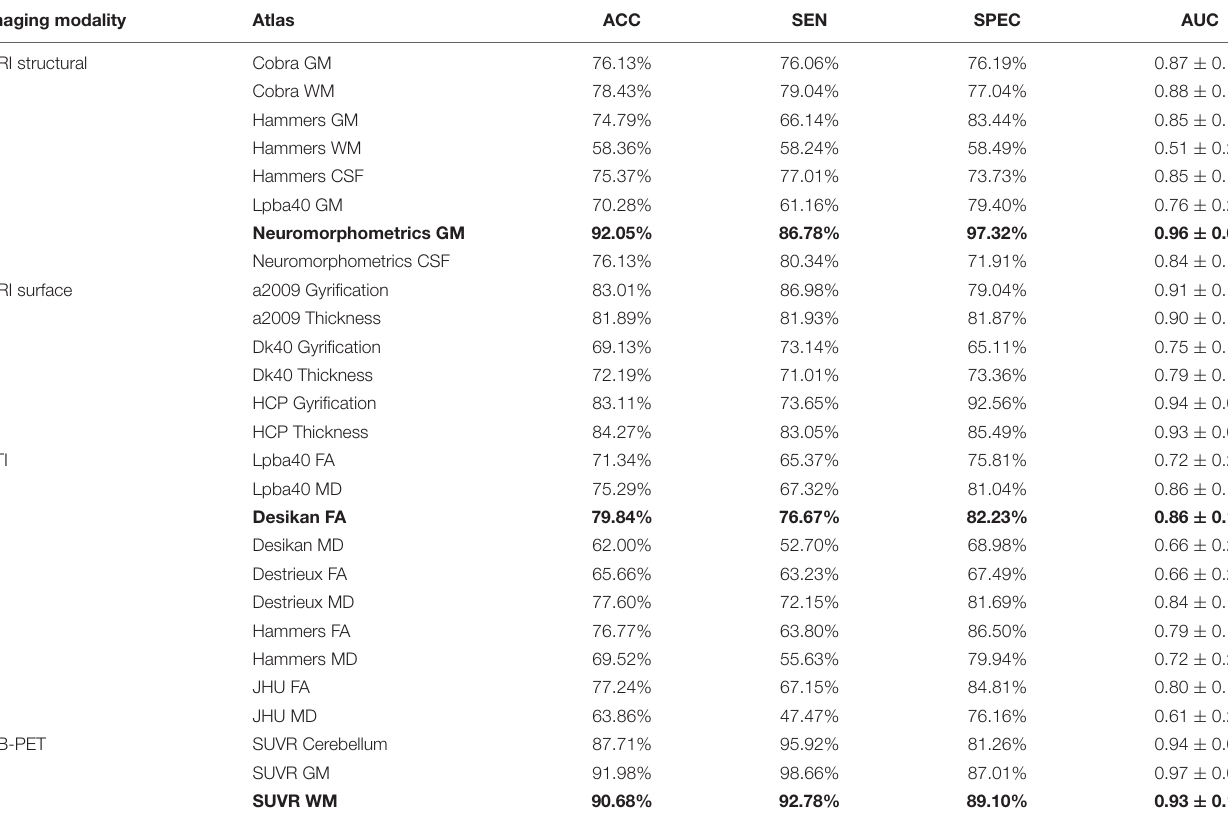
TABLE 5 | Classifier’s performance using embedded-based feature selection for all atlases. Imaging modality